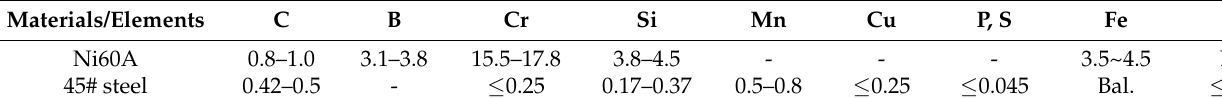
Table 1. Chemical compositions of Ni60A powder and 45# steel substrate (wt.%).